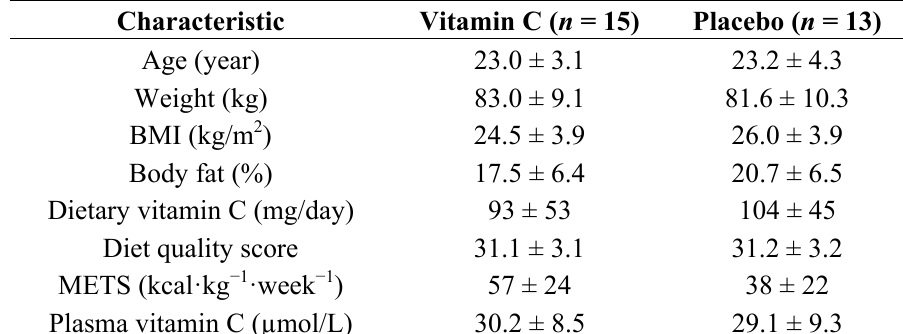
Table 1. Baseline characteristics by group